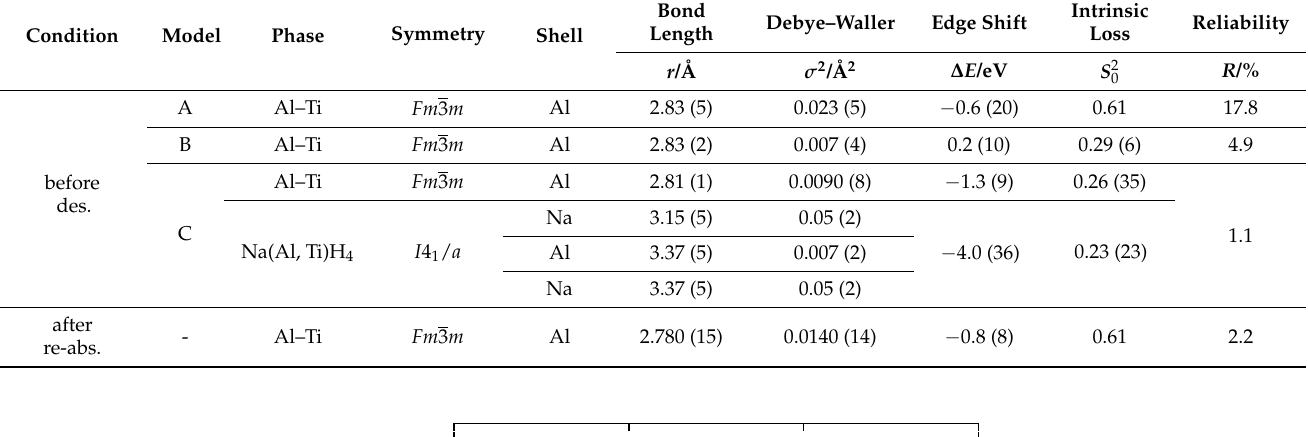
Table 2. Fitting results for the radial distribution functions obtained from the EXAFS spectra of NaAlH 4 –0.02TiCl 3 before the desorption and after the re-absorption of hydrogen.